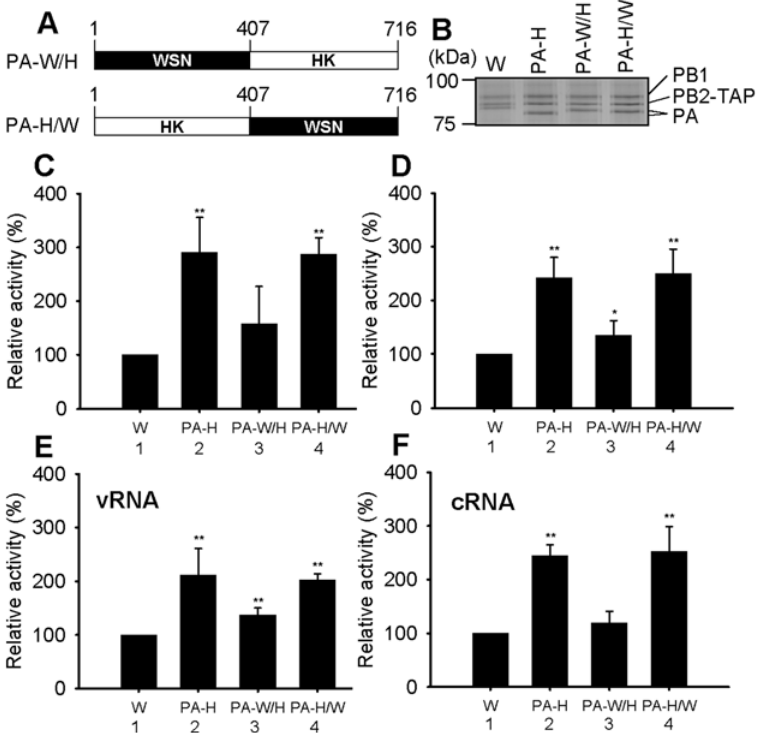
Figure 4. Polymerase activity and UV cross-linking of hybrids containing PA chimeras. (A) Design of PA chimeras. PA-W/H contained the N-terminal amino acids, 1–407 of WSN and C-terminal 408–716 of HK. PA-H/W contained the N-terminal amino acids, 1–407 of HK and C-terminal 408–716 of WSN. (B) 7.5% SDS-PAGE of WSN (W) polymerase and 3 hybrid polymerases with the PA subunit derived from HK (PA-H) or from chimeras, PA-W/H and PA-H/W, analysed by silver staining. The positions of PB1, PB2-TAP and the variable position of the PA subunits are shown. (C) ApG- primed transcription activity. (D) Globin mRNA-primed transcription activity. (E), (F) Promoter binding activity analyzed by UV cross-linking with the model vRNA promoter (in E) or the cRNA promoter (in F). Relative activity is % relative to WSN (W) from 4 independent experiments. * and ** indicate statistically significant differences from W at p , 0.05 and p , 0.01, respectively, in a Student’s t-test.